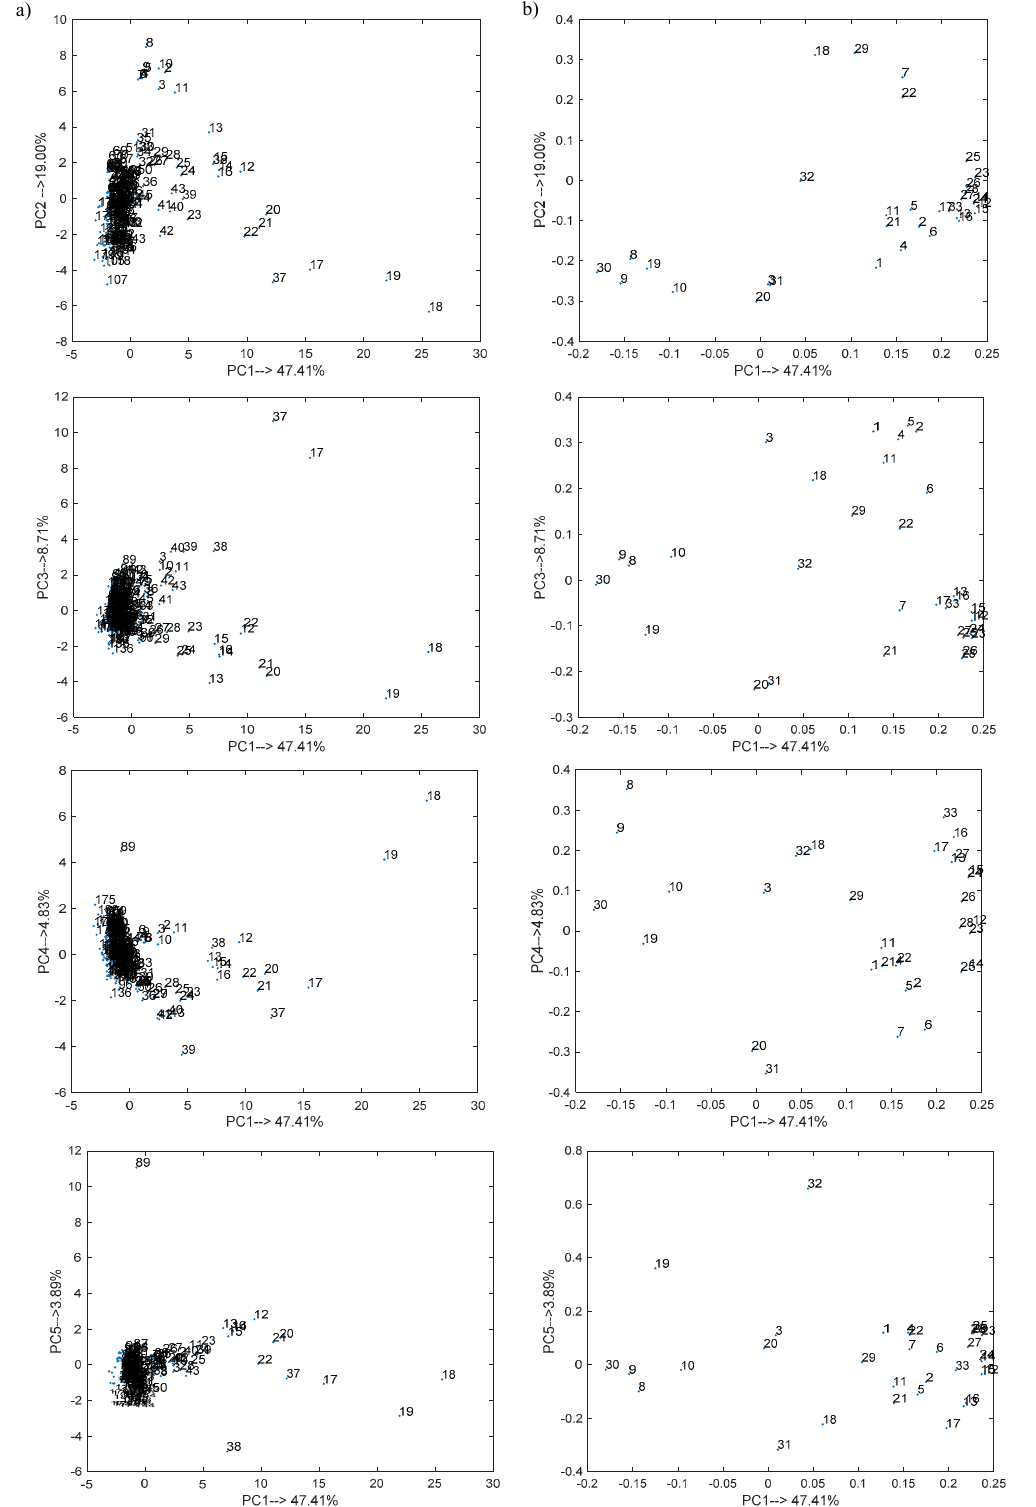
Figure 1. ( a ) Score plots and ( b ) loading plots as a result of PCA for the standardized data X (180 × 33). Additionally, PC2 which describes 19.00% of the data variance shows the difference between objects nos. 17–19 and 37 and objects nos. 2–11. Objects nos. 2–11 characterized with high concentrations of oxygen were measured in the route and hydrogen was measured behind the dam at a distance of